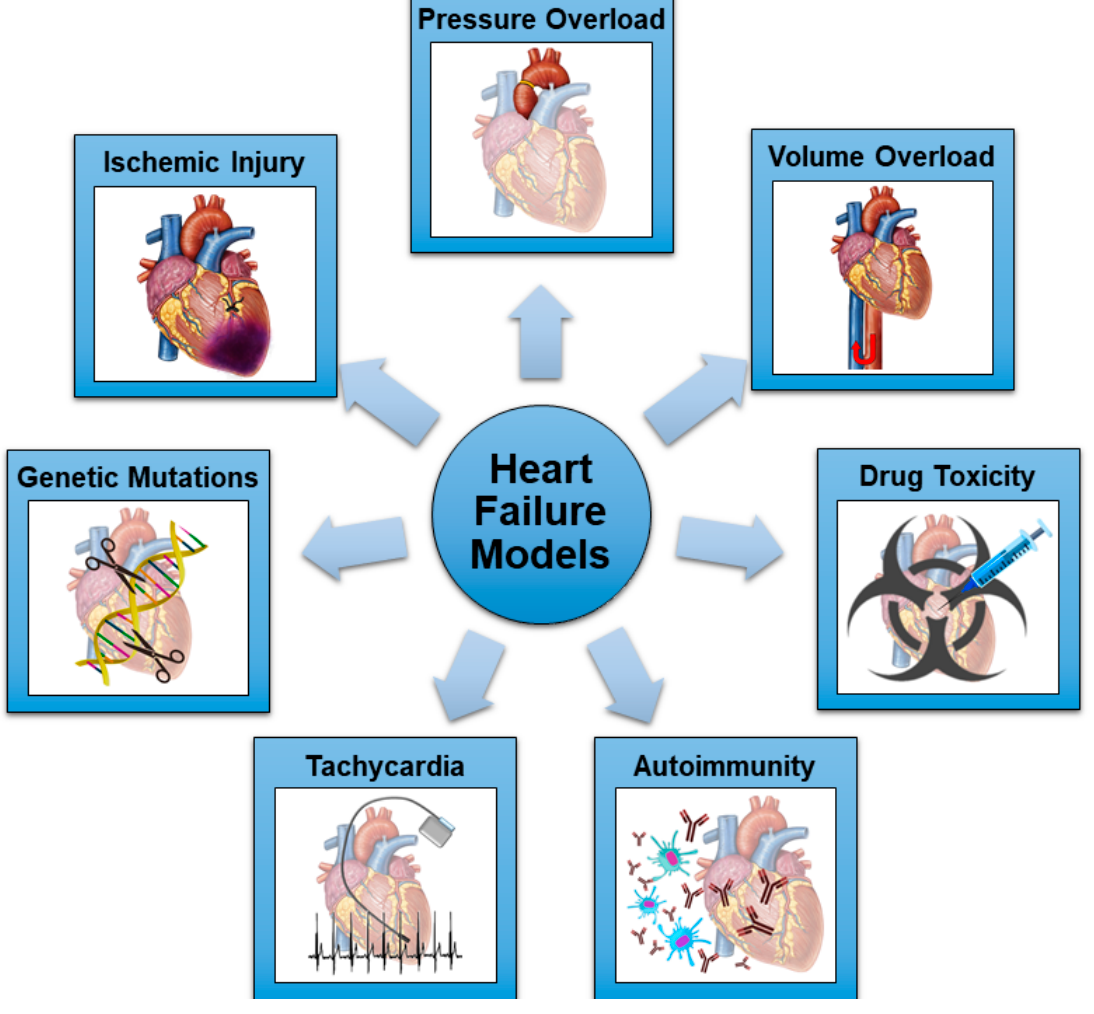
Figure 1. Schematic representation of the most common mechanisms utilized in rodent models of HF.